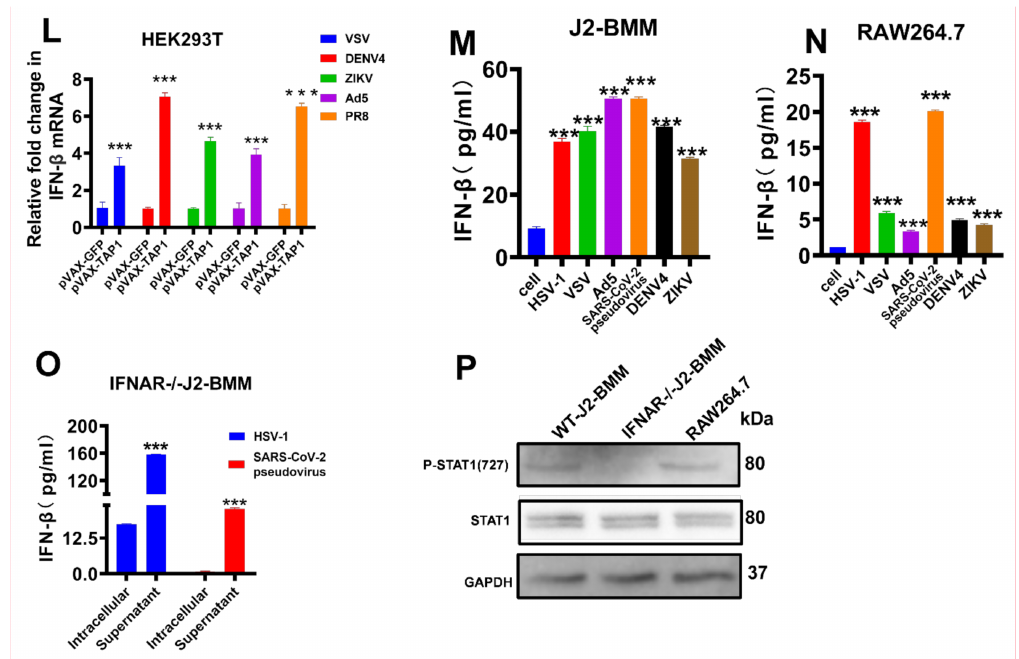
Figure 4. TAP1 significantly promoted the interferon (IFN)- β production through activating the TANK binding kinase-1 (TBK1) and the interferon regulatory factor 3 (IRF3) signaling transduction. ( A ) HEK293T cells were transfected with plasmids expressing GFP or TAP1 (1 µ g/mL) for 24 h, respectively, followed by HSV-1 infection (MOI = 0.25) for 8 h. Then, the expression of IFN- β was quantified by RT-qPCR. ( B ) WT-J2-BMM cells were transfected with siNC, si TAP1 for 24 h, followed by HSV-1 infection (MOI = 0.25) for 8 h. Then, the expression of IFN- β was quantified by RT-qPCR. ( C ) Raw264.7 cells were transfected with siNC, si TAP1 for 24 h, followed by HSV-1 infection (MOI = 0.25) for 8 h. Then, the expression of IFN- β was quantified by RT-qPCR. ( D ) THP-1 cells were transfected with TAP1 -expressing plasmid in different concentration (5 µ g/mL, 1.25 µ g/mL, 0.3 µ g/mL) for 24 h, followed by HSV-1 infection (MOI = 0.25). Then, the expression of IFN- β in cell lysates was determined by ELISA kits. ( E – G ) HEK293T, THP-1 or Raw 264.7 cells were transfected with plasmids expressing GFP or TAP1 (1 µ g/mL) for 24 h respectively, followed by HSV-1 infection (MOI = 0.25) for 8 h. Then, the expression of targeted proteins was detected by Western blot. The relative ratios of targeted protein and GAPDH were marked at the bottom of the pictures. ( H , I ) HEK293T cells were transfected with plasmids expressing GFP or TAP1 for 24 h, followed by viral infections (HSV-1 or PR8) for 24 h at MOI of 1. Then, the expression of targeted proteins was detected by Western blot. The relative ratios of targeted protein and GAPDH were marked at the bottom of the pictures. ( J , K ) WT-J2-BMM or HEK293T cells were transfected with siNC or si TAP1 for 24 h, followed by HSV-1 infection (MOI = 0.25) for 8 h. Then, the expression of targeted proteins was detected by Western blot. The relative ratios of targeted protein and GAPDH were marked at the bottom of the pictures. ( L ) HEK293T cells were transfected with or without TAP1 -expressing plasmid for 24 h, followed by viral infections for 8 h at MOI of 1, including VSV, ZIKV, DENV4, Ad5 and PR8. Then, the expression of IFN- β was quantified by RT-qPCR. ( M , N ) WT-J2-BMM or Raw 264.7 cells were transfected with TAP1 -expressing plasmid for 24 h, followed by viral infections for 24 h at 1 MOI, including HSV-1, VSV, Ad5, SARS-CoV-2 pseudovirus, ZIKV, DENV4. Then, the expression of IFN- β in cell lysates was determined by ELISA kits. ( O ) ( IFNAR − / − )-J2-BMM cells were transfected with TAP1-expressing plasmid for 24 h, followed by HSV-1 or SARS-CoV-2 pseudovirus infection for 24 h. Then, the expression of IFN- β in cell lysates and supernatant was determined by ELISA kits. ( P ) WT-J2-BMM, ( IFNAR − / − )-J2-BMM, and Raw 264.7 cells were transfected with TAP1 -expressing plasmid for 24 h, followed by HSV-1 infection for 24 h. Then, the level of STAT1 phosphorylation and total STAT1 was measured by Western blot. The data from at least triplicates were shown as the mean ± SD. * p < 0.05, ** p < 0.01 and *** p <